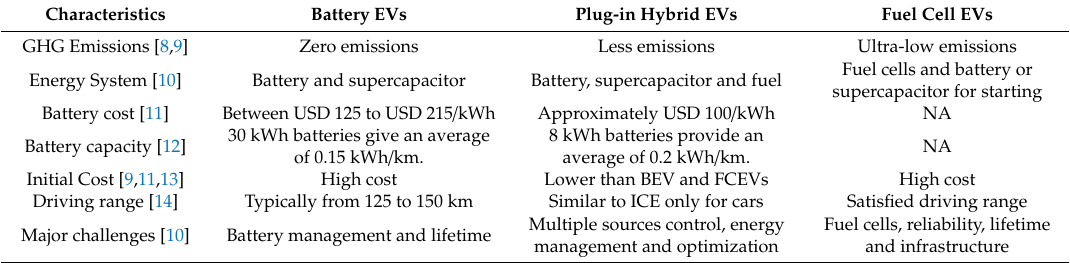
Table 1. Comparison between BEVs and PHEVs.